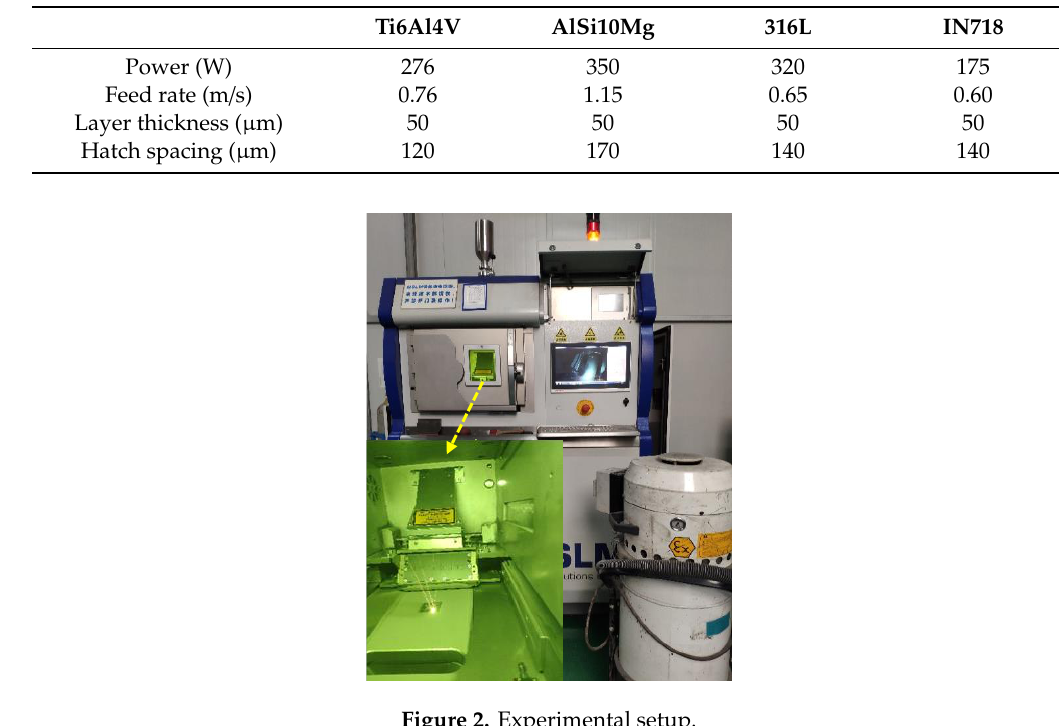
Table 1. SLM parameters of four typical alloys.